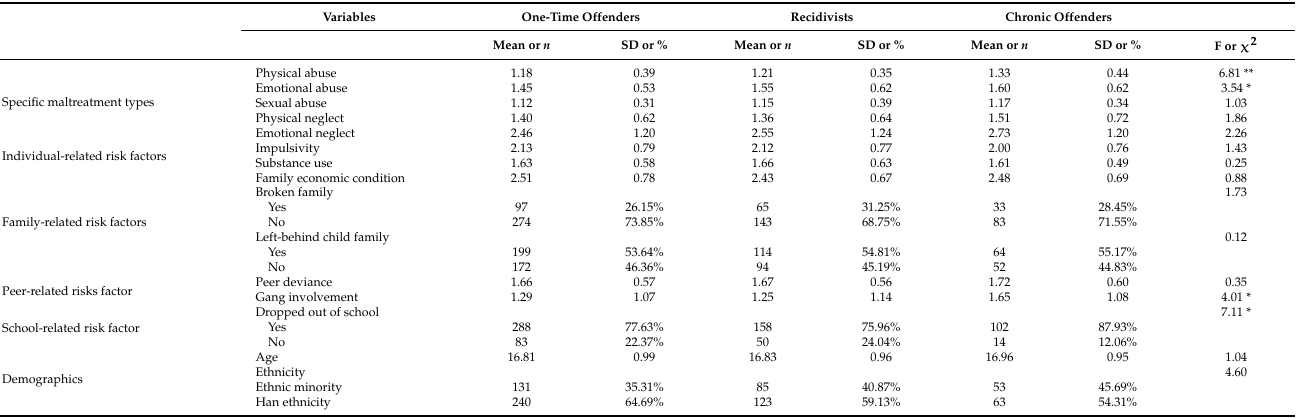
Table 3. Group differences in the independent variables and control